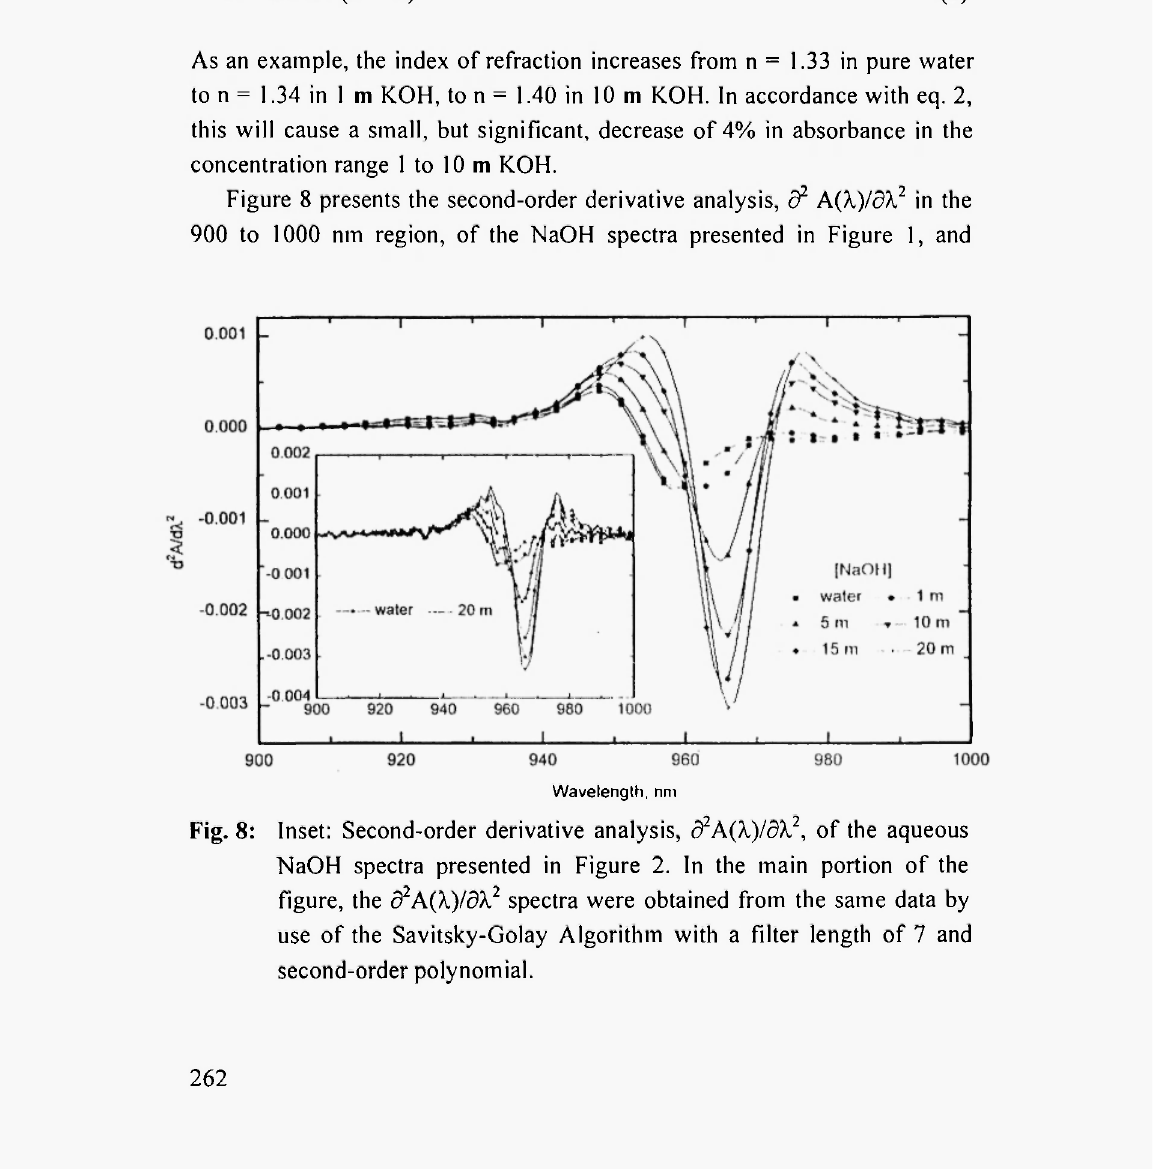
Fig. 8: Inset: Second-order derivative analysis, (?Α(λ)/δλ 2 , of the